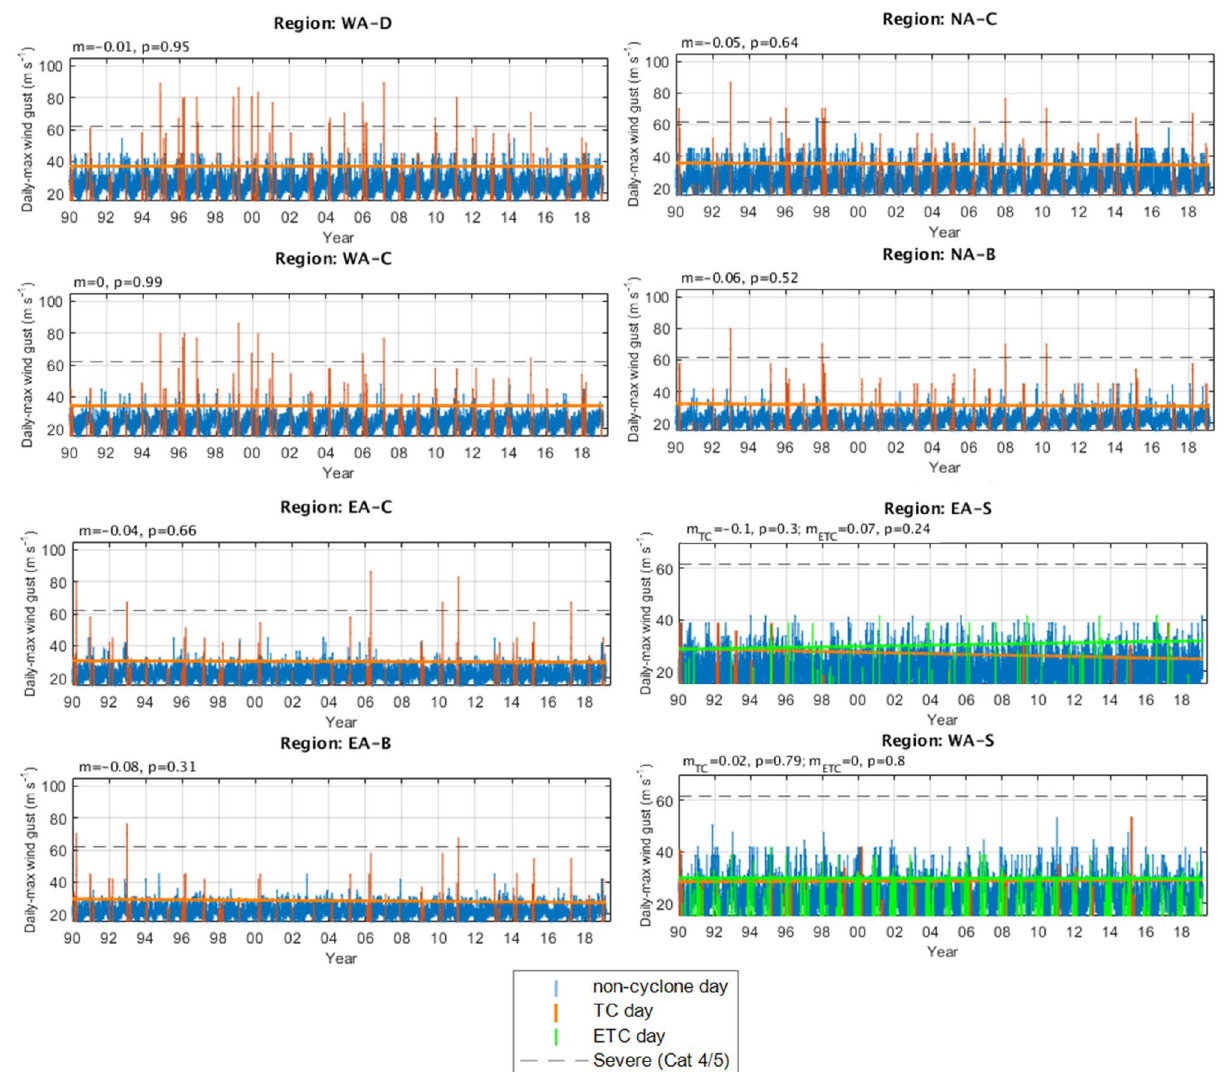
Figure 3. Time series and trend lines of calibrated BARRA reanalysis daily maximum wind gusts (3-s) occurring in each region. Daily maximum wind gusts are classified as “TC-related”, “ETC-related”, or “non- cyclone related” (see legend). Linear trend lines are shown for TC-day max winds (orange) and ETC-day max winds (green, where applicable). The estimate of the gradient ( m ) and associated p -value ( p ) for these trend lines are shown above each time series. Note that the gradient are shown for years (rather than TC days) for